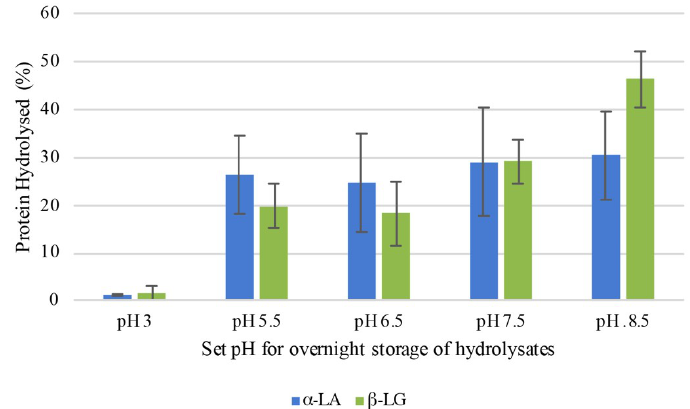
Figure2. Percentagechangeinhydrolysisof α -lactalbumin( α -LA)and β -lactoglobulin( β -LG)following Figure 2. Percentage change in hydrolysis of α-lactalbumin (α-LA) and β-lactoglobulin (β-LG) overnight storage at room temperature (20 ◦ C) and di ff erent pH values (3.0, 5.5, 6.5, 7.5, 8.5) of a tryptic following overnight storage at room temperature (20 °C) and different pH values (3.0, 5.5, 6.5, 7.5, 8.5) of a tryptic whey protein isolate hydrolysate, analysed in triplicate. whey protein isolate hydrolysate, analysed in